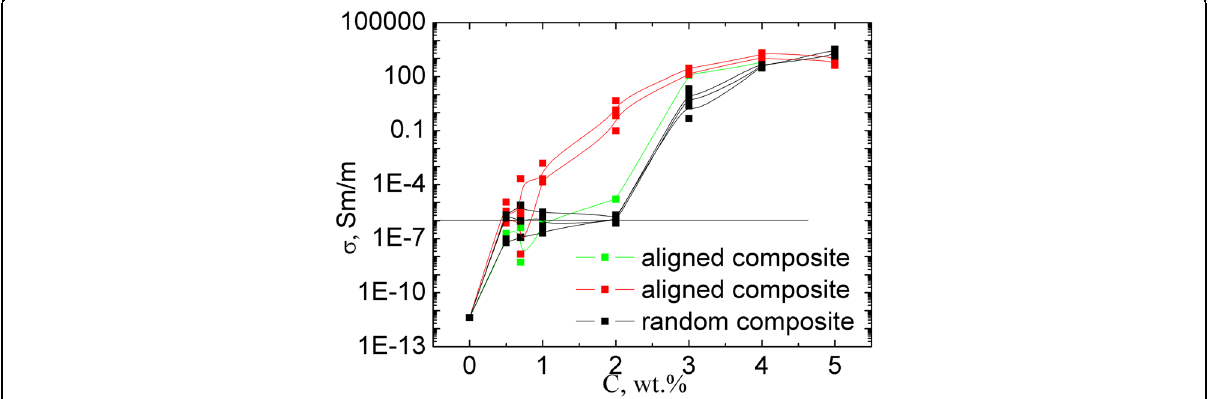
Fig. 10 Concentration dependence of electrical conductivity of GNPs/Larit 285 composites with aligned and with random filler distribution in logarithmic